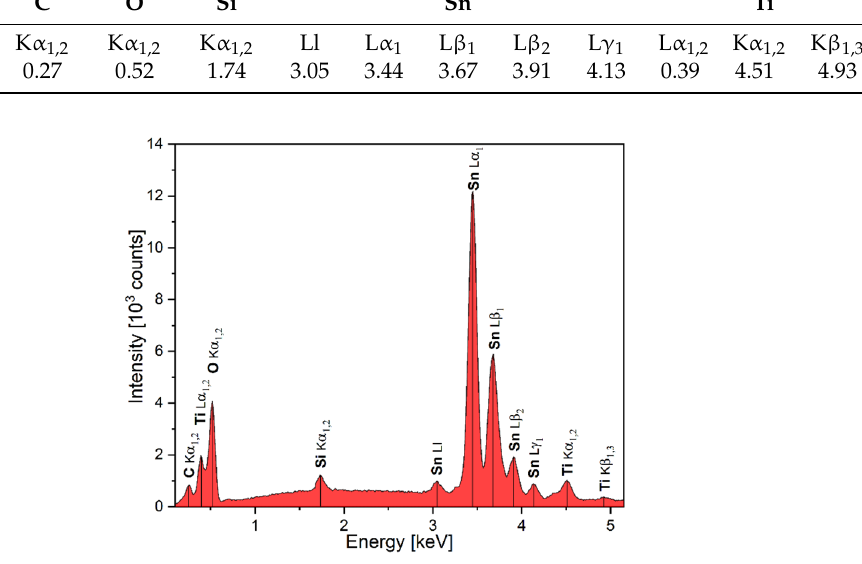
Figure 3. EDS spectrum of the TiO 2 /FTO/glass stack. Characteristic lines are tabulated in Table 1. Table 1. Characteristic lines received from the EDS spectrum of the TiO 2 /FTO/glass stack with energies in keV.